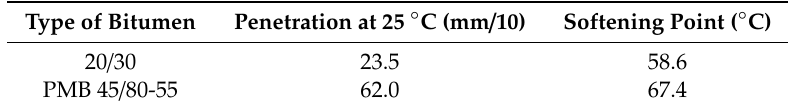
Table 1. Results of penetration and softening point determination of asphalt binders used in the production of analysed asphalt mixtures.